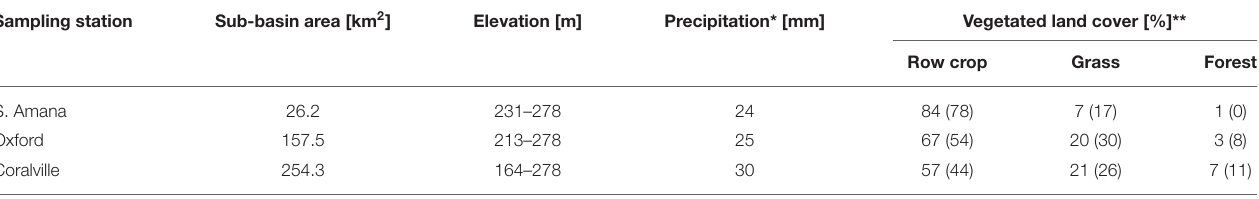
TABLE 1 | Subbasin